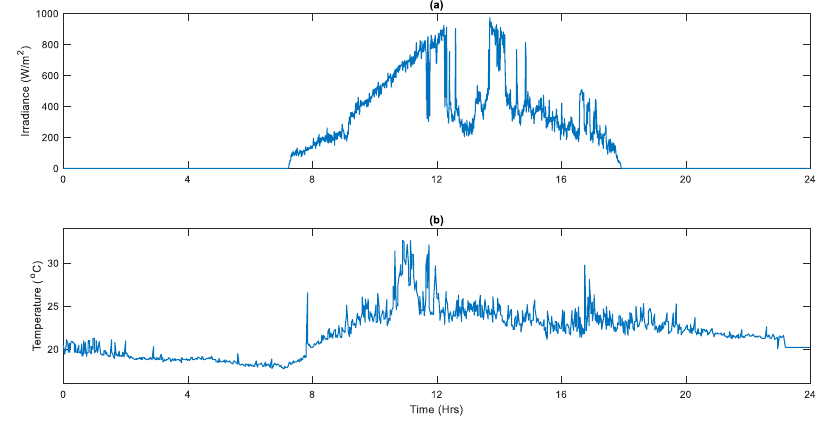
Figure 9. Weather data: ( a ) irradiance and ( b ) temperature.